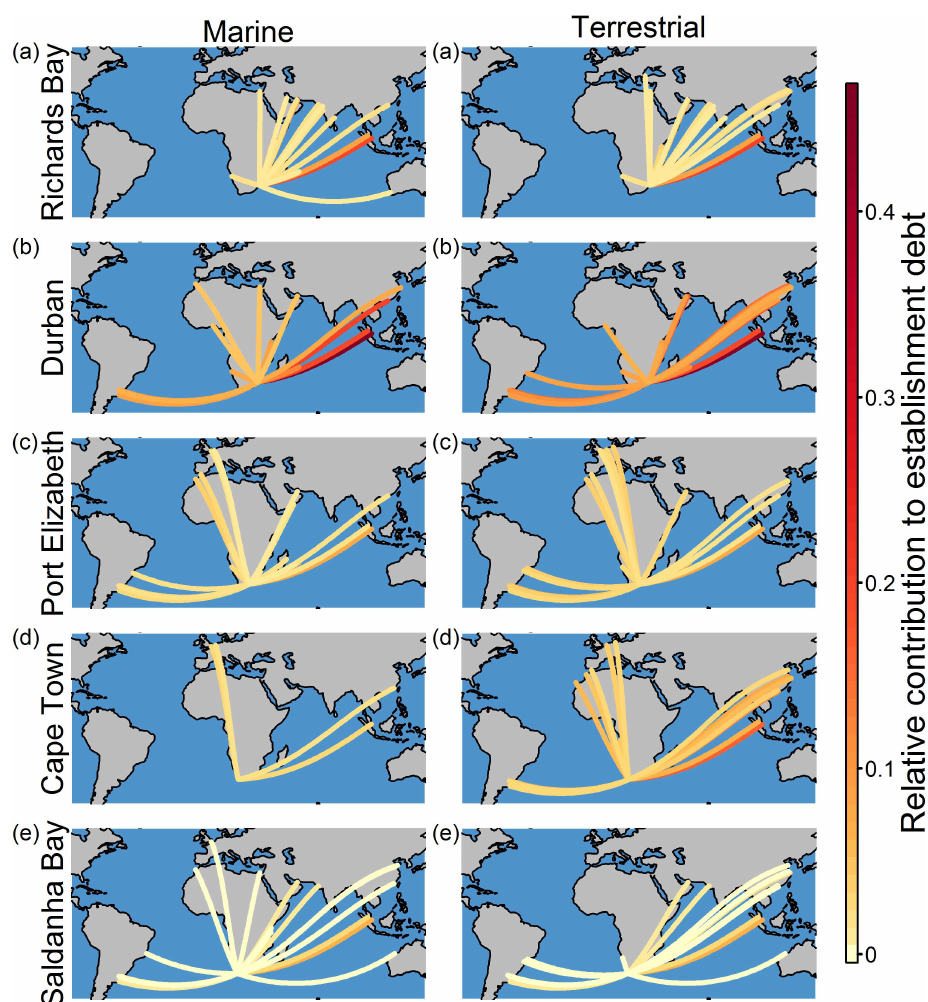
Fig 2. For each South African port, the twenty shippingroutes from foreign ports with the highestrelative contribution to marine and terrestrial establishment debt: (a) RichardsBay, (b) Durban,(c) Port Elizabeth, (d) Cape Town and (e) SaldanhaBay. The depictedroutes are not the actual routes followedby ships.